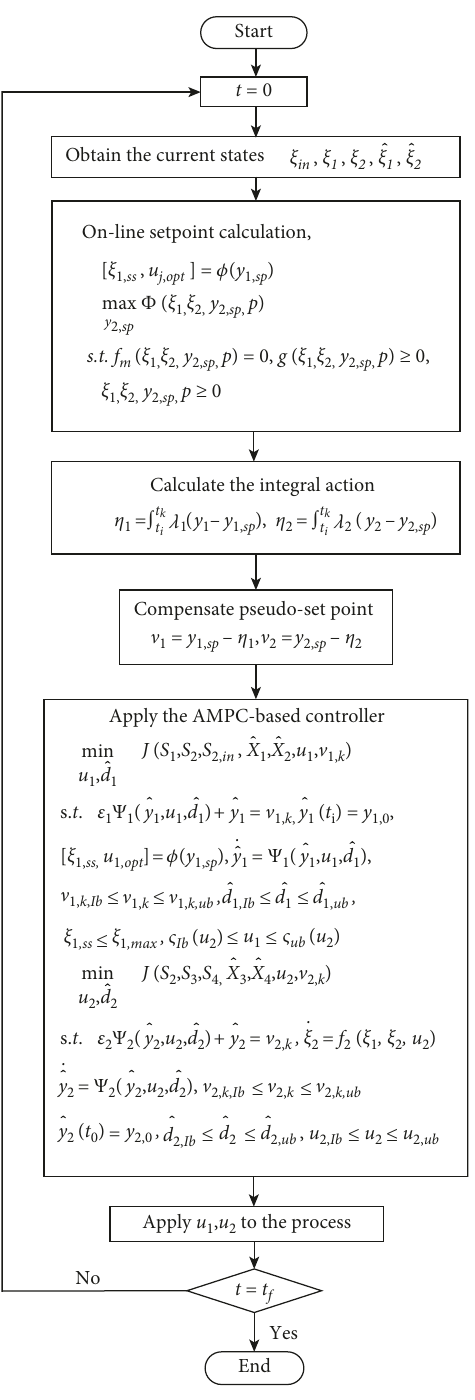
Figure 4: Flowchart of the developed control